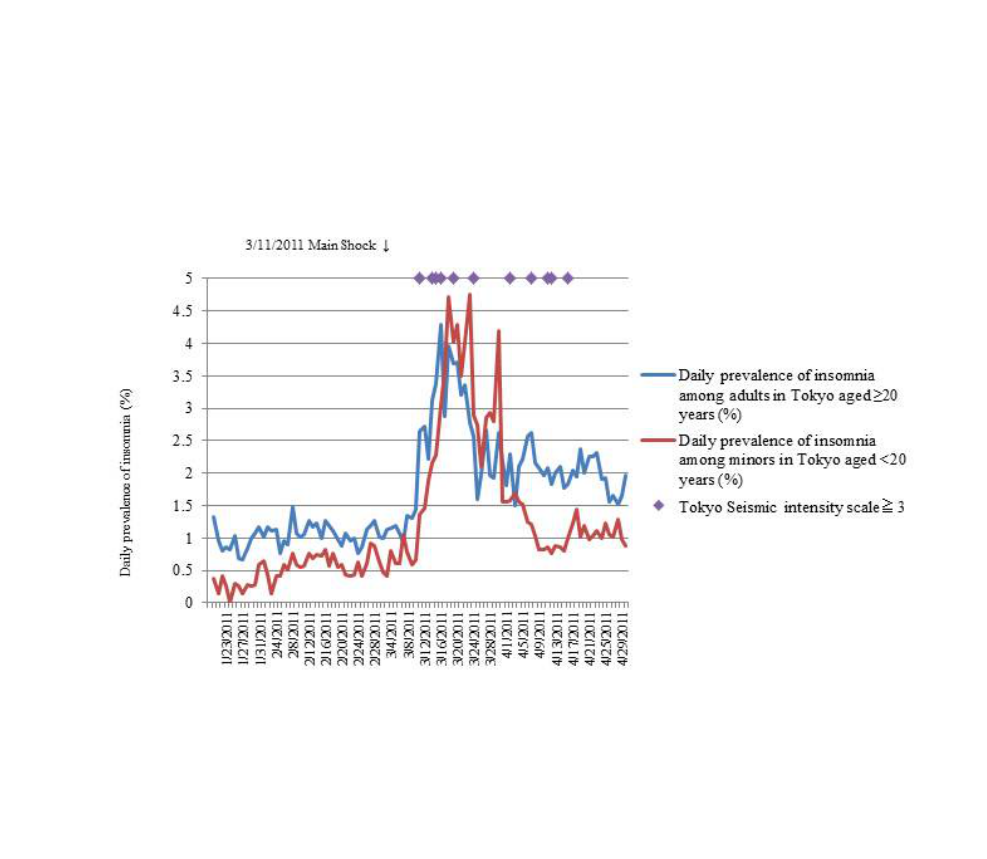
Figure 2. Prevalence of insomnia in Tokyo. The prevalence of insomnia increased after the earthquake for both adults and minors in